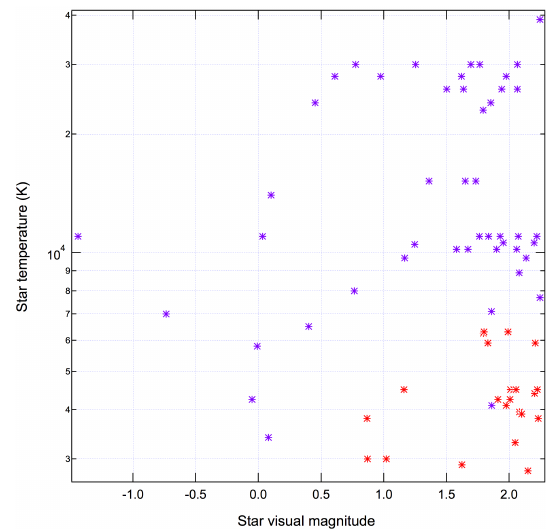
Fig. 4. Diagram of the star temperature (UV spectrum) as a function of star magnitude. Individual tests show that stars that are not both dim and cool, provide the best retrieval conditions. These good stars are indicated with purple asterisks, whereas the “worse retrieval” group is marked with red